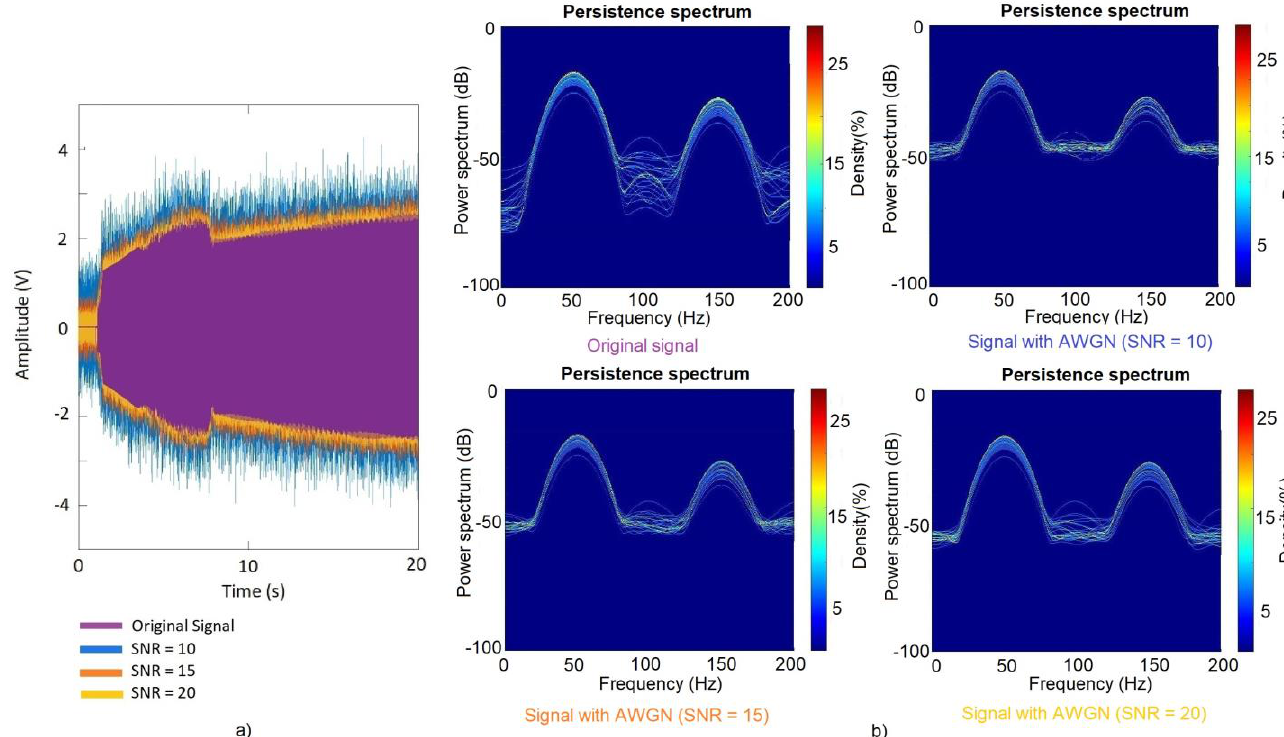
Figure 5. ( a ) Original stray-flux signal and different signals with AWGN overlapped. ( b ) Persistence Spectra of the original signal and the three signals with different AWGN.